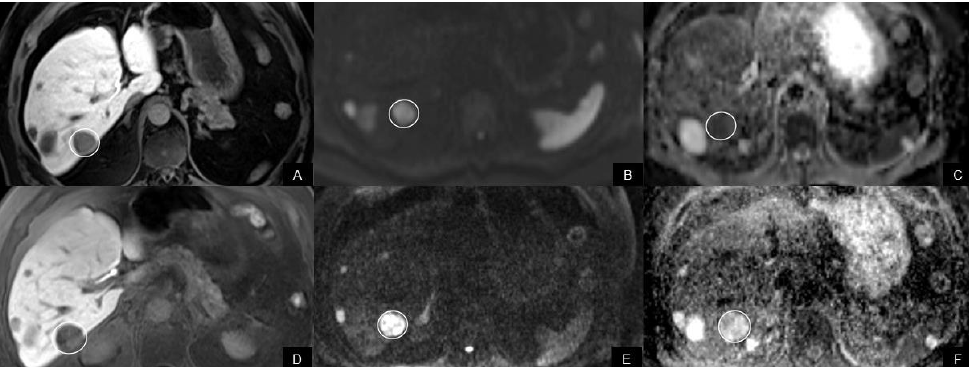
Figure 4. An 74-year-old man with hepatic metastasis of pNET classified as a nonresponder. ( A , D ) Under everolimus, the metastasis (arrow) increased in size from ( A ) 25 mm to ( D ) 29 mm on the axial contrast-enhanced T1W image (liver-specific phase) ( B , D ). On both ( B ) pre- and ( D ) posttherapeutic MRI, the metastasis (arrow) showed restricted diffusion with high signal on DWI image with high b-value. ( C ) ADCmin value of the metastasis (circle) on pretherapeutic ADC map ( E ) was 747 × 10 −3 mm 2 /s and increased to 811 × 10 −3 mm 2 /s on ( F ) the post-therapeutic scan.